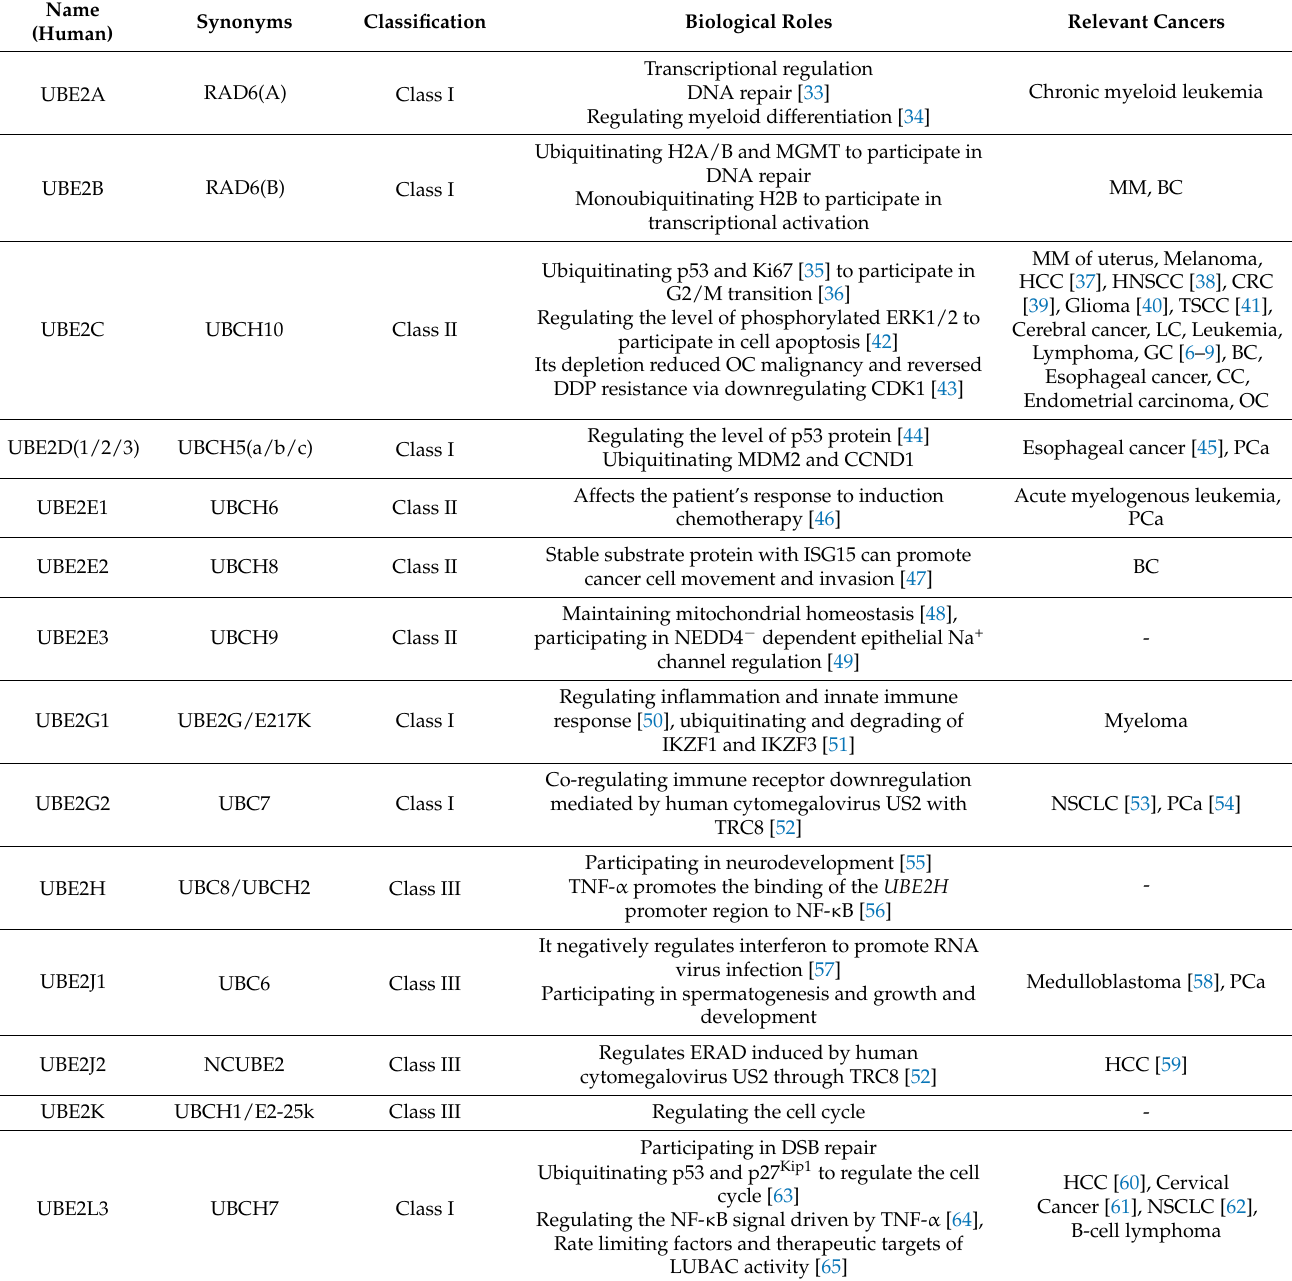
Table 1. E2s, its synonyms, classification, relevant biological roles, and involvement in